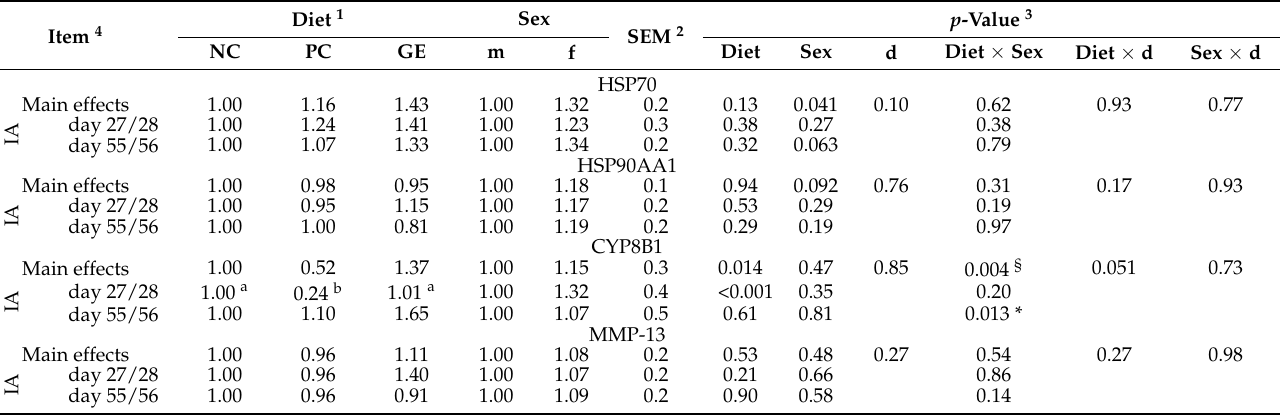
Table 9. Expression of selected marker genes of stress involved in tissue repair and immune response in liver of weaning piglets fed GE compared to NC and PC. NC was set to